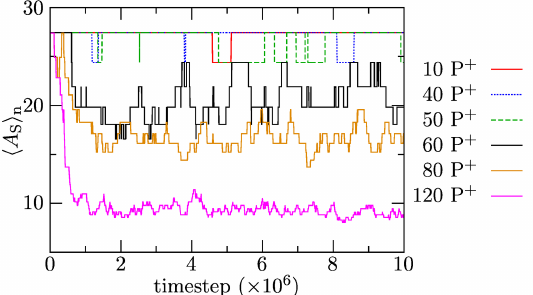
Figure 8. Average association number, (cid:104) A S (cid:105) n , as a function of simulation time for systems with added P +